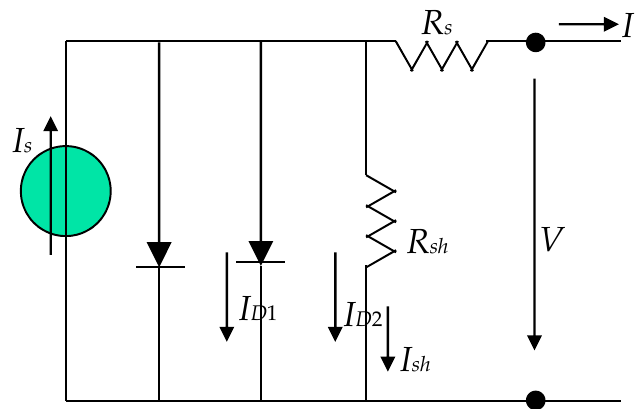
Figure 1. Equivalent circuit of a photovoltaic (PV) module—2D + 7P model.